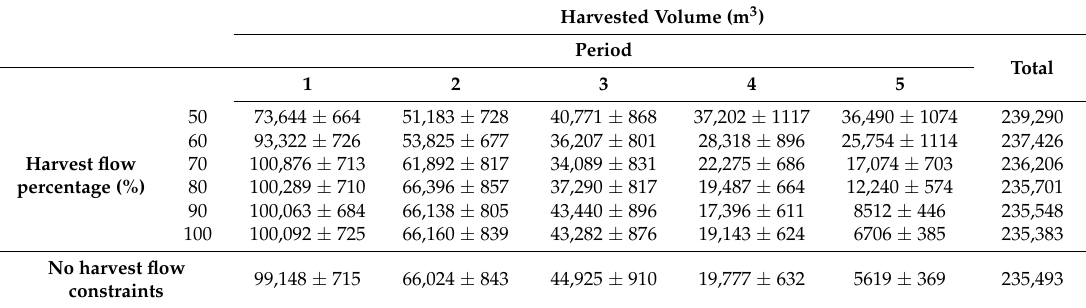
Table 6. The average periodic and total harvested volumes and their standard deviations of different harvest flow percentages obtained by simulation experiments for the ROB model´s results for 50% protection level in the first